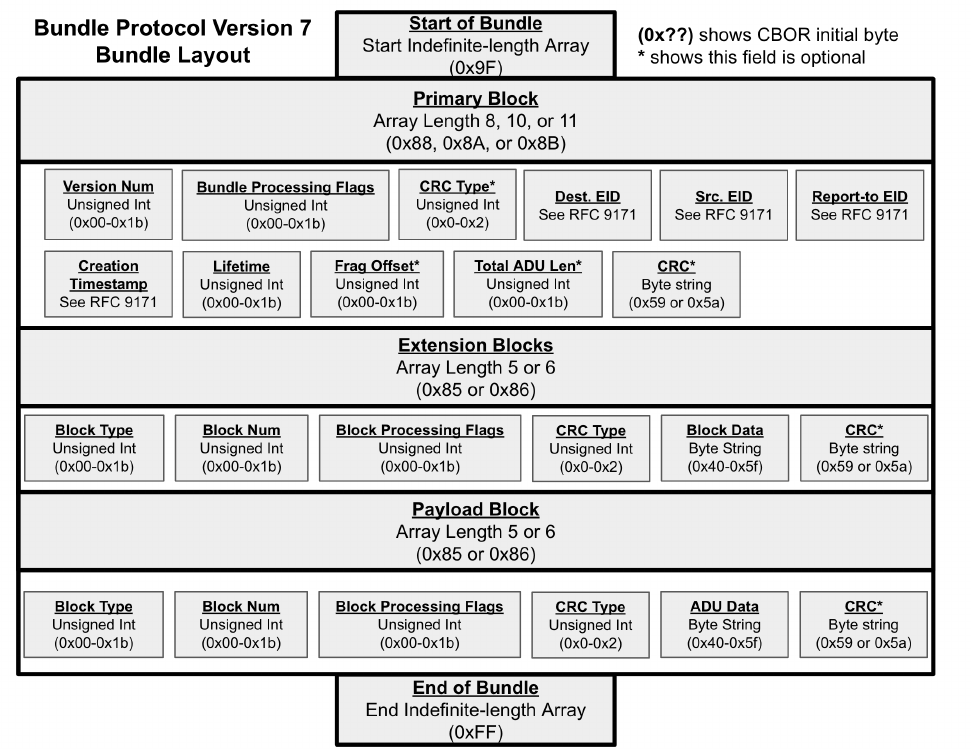
Figure 5. Layout of BPv7 bundles. A bundle is encoded as an indefinite–length array of blocks, and blocks are encoded as definite–length arrays of fields. The size of each field is determined by its data type and defined length in its initial byte (shown in